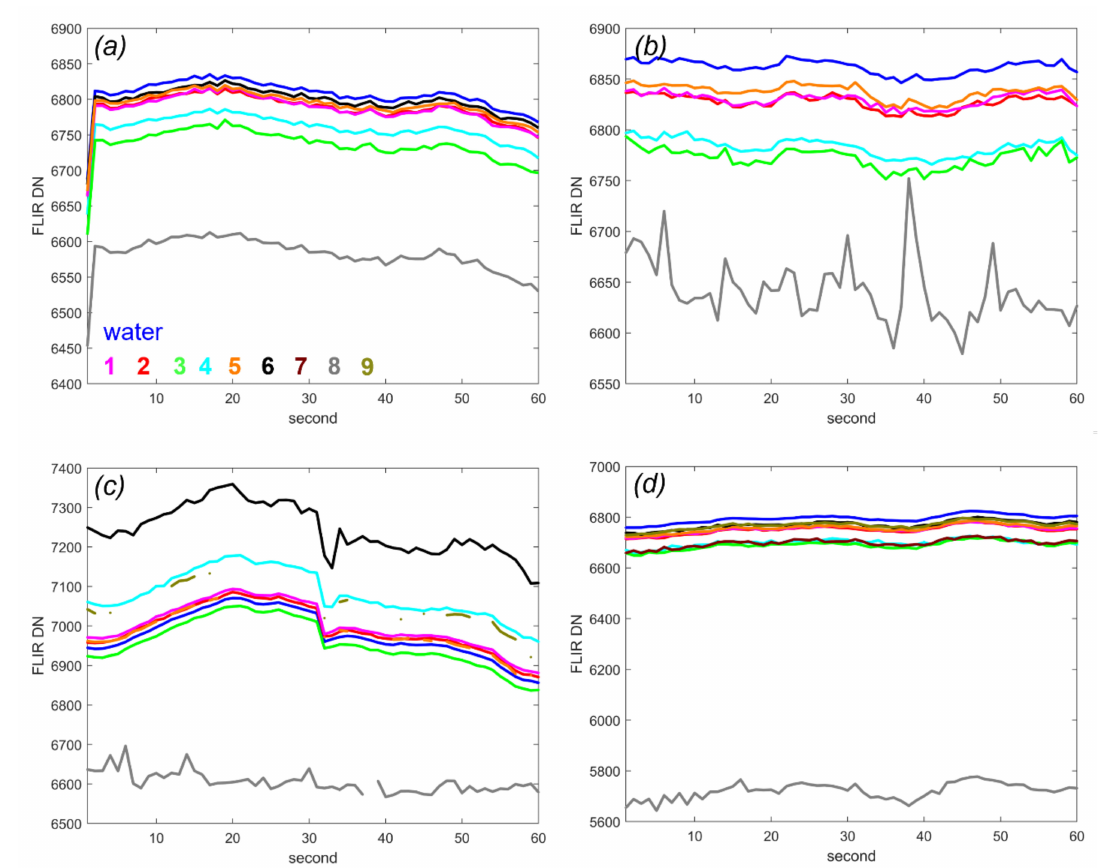
Figure A5. DN, 1 Hz data obtained during recording minute, after flatfield correction with sigma = 30, for ( a ) survey 1, ( b ) survey 2, ( c ), survey 3, and ( d ) survey 4. Numbers indicate targets: 1-small